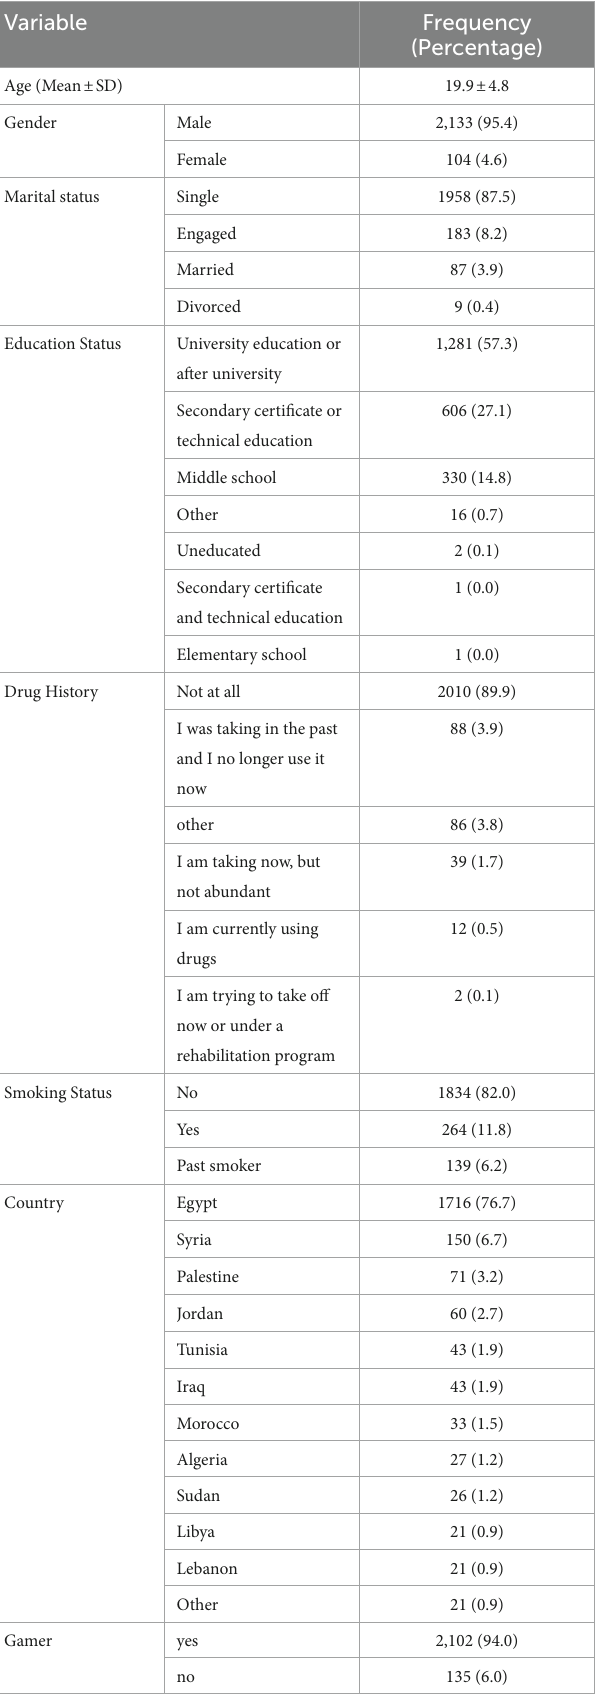
TABLE 1 Baseline characteristics of the study